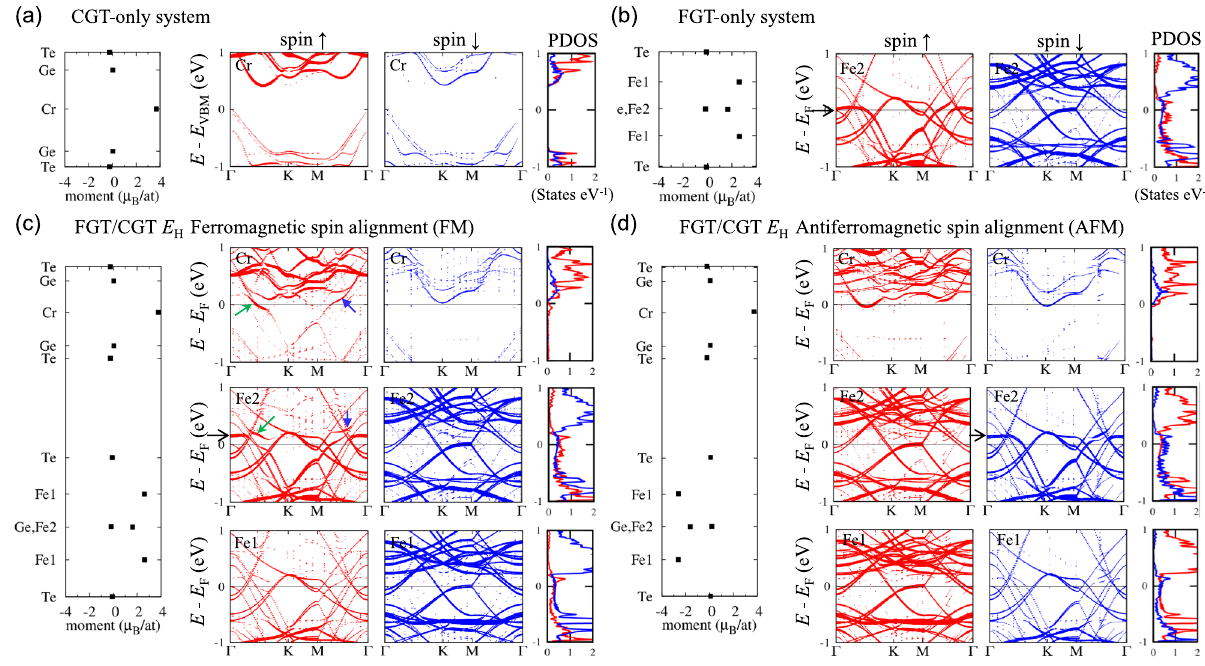
Figure 3. Magnetic moment (left panels), projected band structures (middle panels), and atom projected density of states (PDOS, right panels) of ( a ) the CGT-only system, ( b ) FGT-only system, ( c ) FM FGT/CGT heterobilayer of E H , and ( d ) AFM FGT/CGT heterobilayer of E H . The band structures are obtained by the noncollinear PBE + U + SOC method ( U = 3.5 eV and J = 1.0 eV applied to Cr 3 d orbitals). The band structures are projected onto a Cr or Fe atom; the color intensity corresponds to the projection magnitude. In ( c ), green and blue arrows indicate the hybridized bands between Cr and Fe2 atoms. In ( b )–( d ), the band change of Fe2 atoms near the Ŵ point is indicated by black